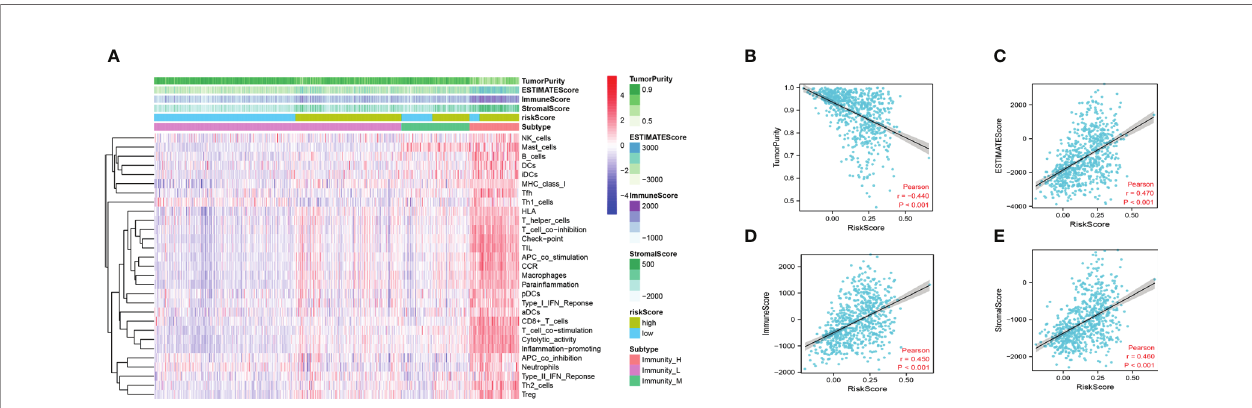
FIGURE 7 | Immune in fi ltration patterns of low- and high-risk score analyzed by ssGSEA methods in glioma from the CGGA dataset. (A) Heatmap revealing the scores of immune cells in low, middle, and high immunities. (B – E) Scatter plot showing the correlation between risk score and tumor purity, ESTIMATE, immune and stromal score. CGGA, Chinese Glioma Genome Atlas; ssGSEA, single-sample gene set enrichment analysis.